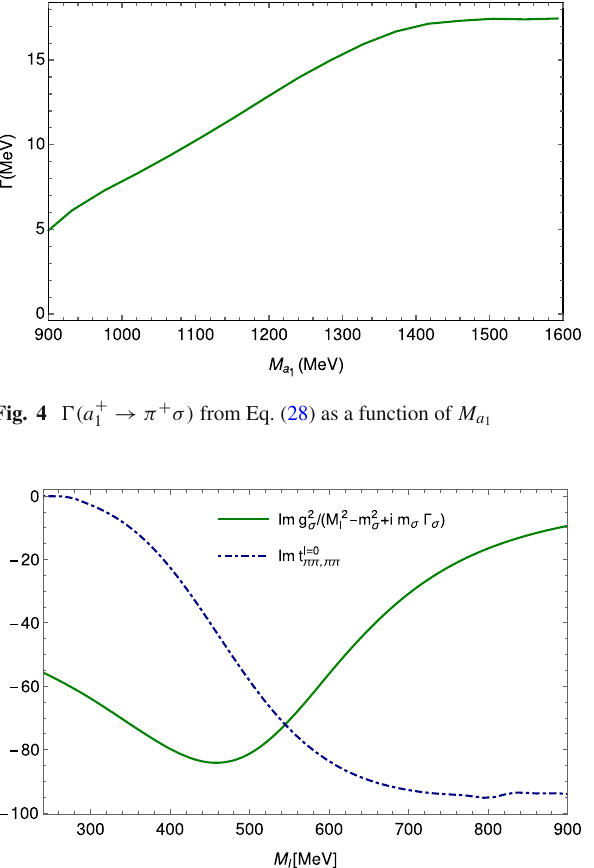
Fig. 5 Comparison of the imaginary parts of g 2 σ /( M 2 and t I = 0 ππ,ππ